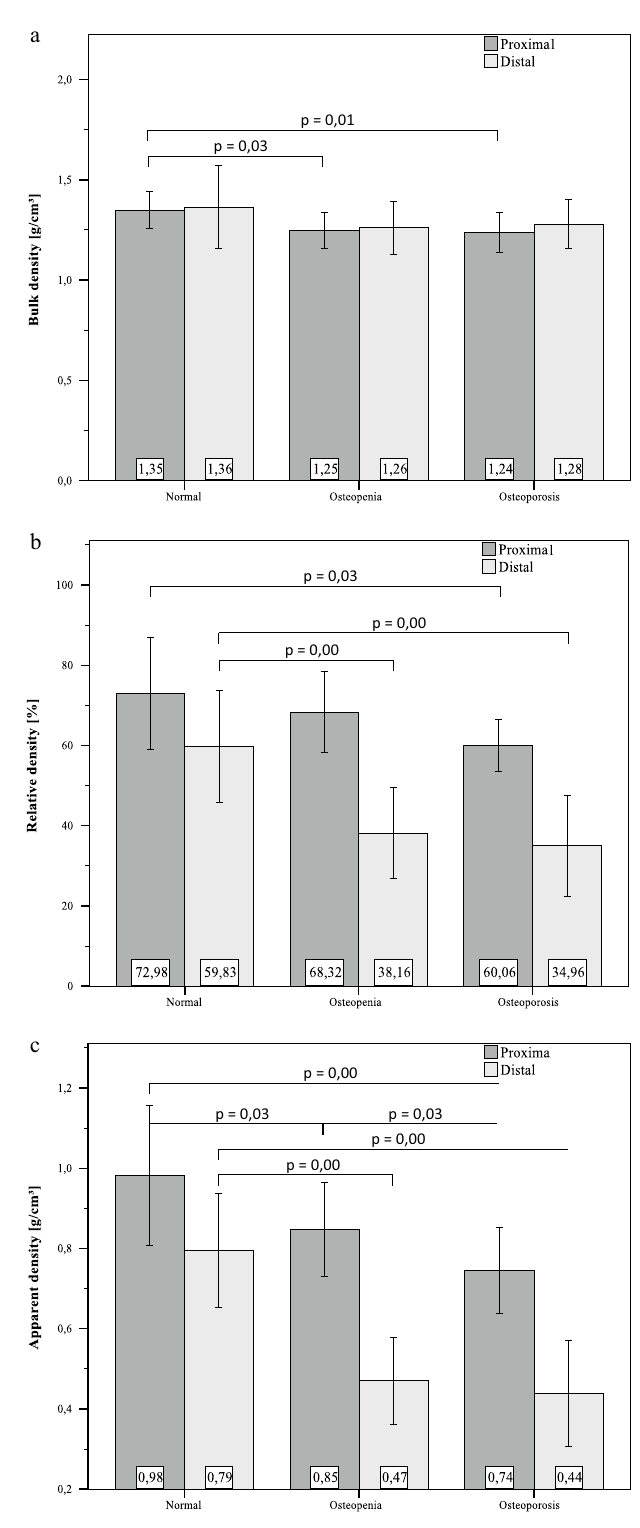
Figure 3. Mean density values of the density samples collected proximally and distally oriented to the mechanical specimen. The data grouped regarding WHO classification for osteoporosis based on BMD measurements of each donor bone. Bulk density ρ b ( a ) stays roughly constant with low differences between sites. Apparent density ρ app ( b ) and relative density ρ r ( c ) show both great differences both between sites and groups. all significant differences are marked with their specific p-value from independent